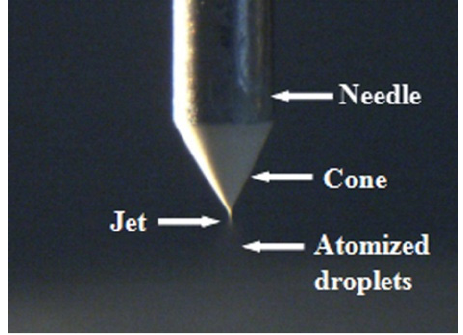
Figure 1. Cone-jet mode of the E-jet Figure 1. Cone ‐ jet mode of the E ‐ jet deposition.